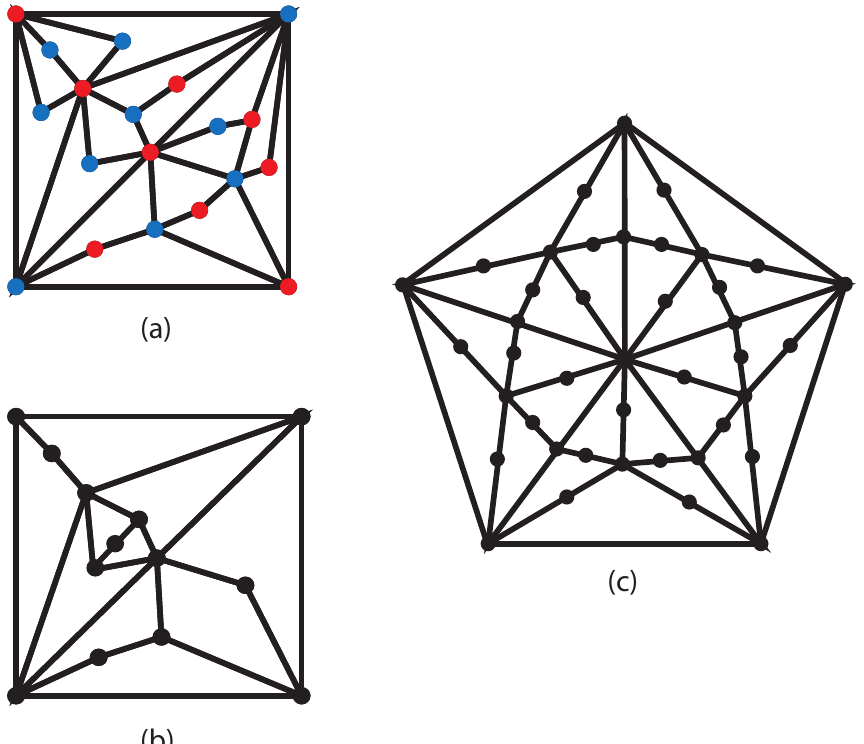
Figure 7. ( a ) Tetragon-based networks are bipartite. ( b ) An example of a particular realization of a randon tetragon-based graph. ( c ) An example of a 2nd-generation deterministic pentagon-based